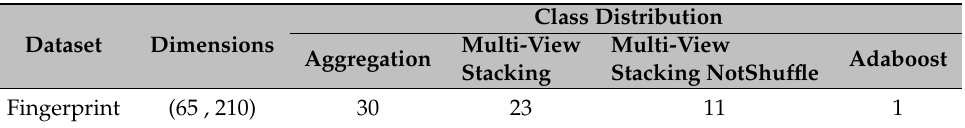
Table 5. Important data on the Fingerprint dataset.